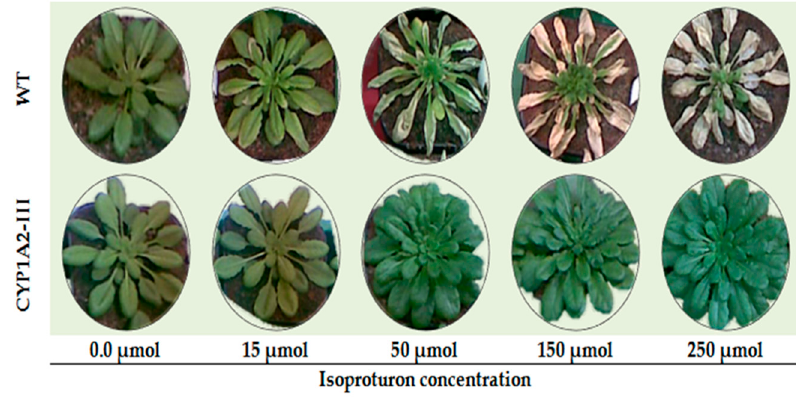
Figure 4. Effects of isoproturon application on the phenotypes of wild type (WT) and CYP1A2 transgenic A. thaliana plants. Wild type (WT) and CYP1A2 -III transgenic A. thaliana plants.